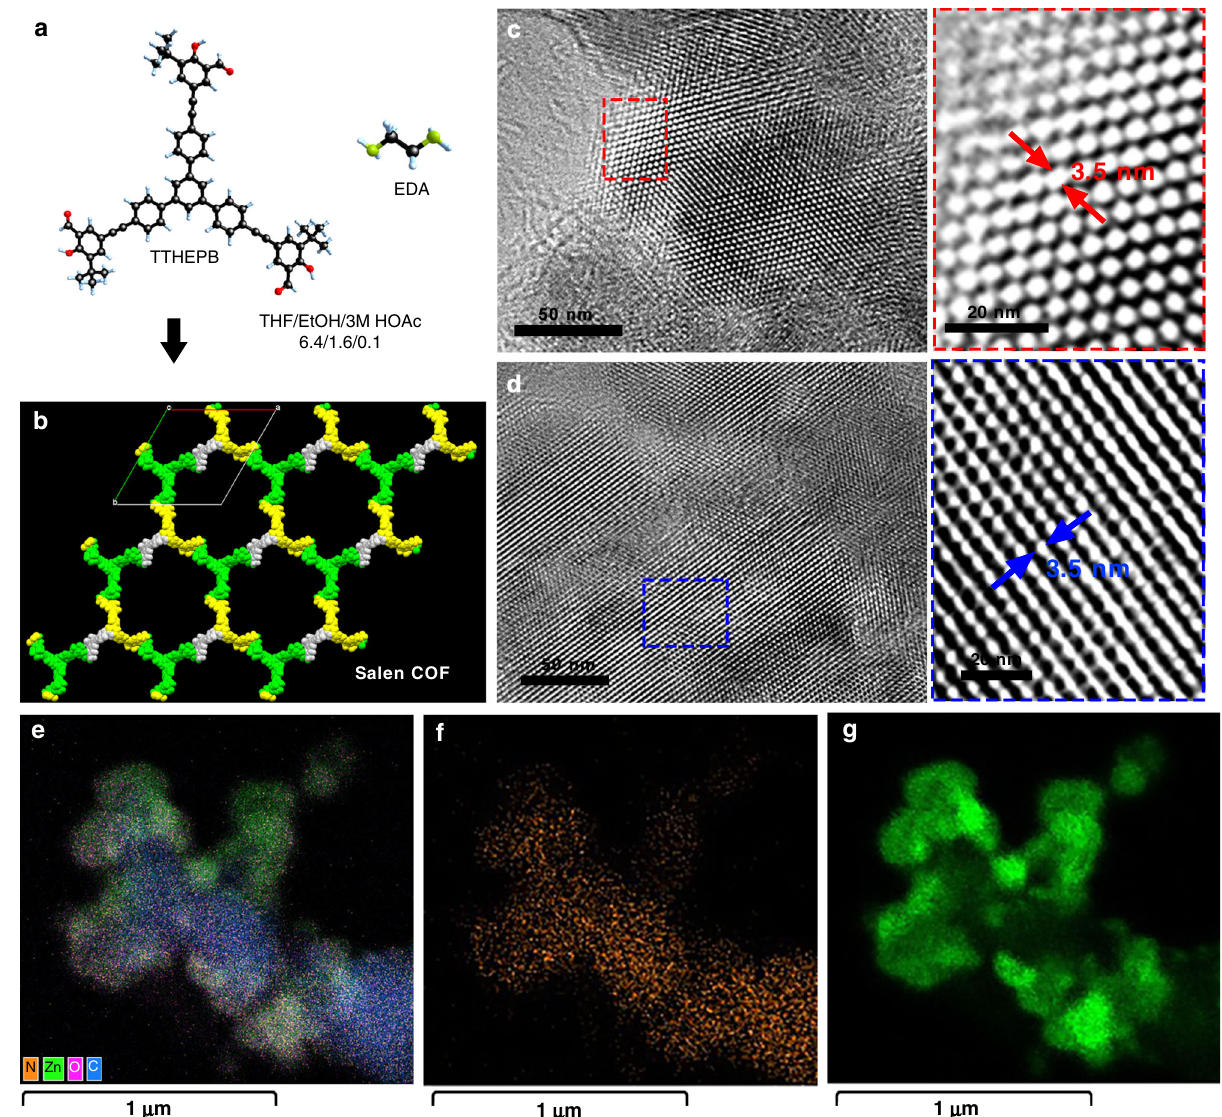
Fig. 4 Synthesis and structure of Zn-Salen-COF-SDU113. a , b Synthesis of Zn-Salen-COF-SDU113. c , d TEM images of Zn-Salen-COF-SDU113 (the dotted border of different colours corresponds to different areas). e – g Energy-dispersive X-ray spectroscopy (EDS) mapping images of Zn-Salen-COF-SDU113 (orange: N elements; green: Zn